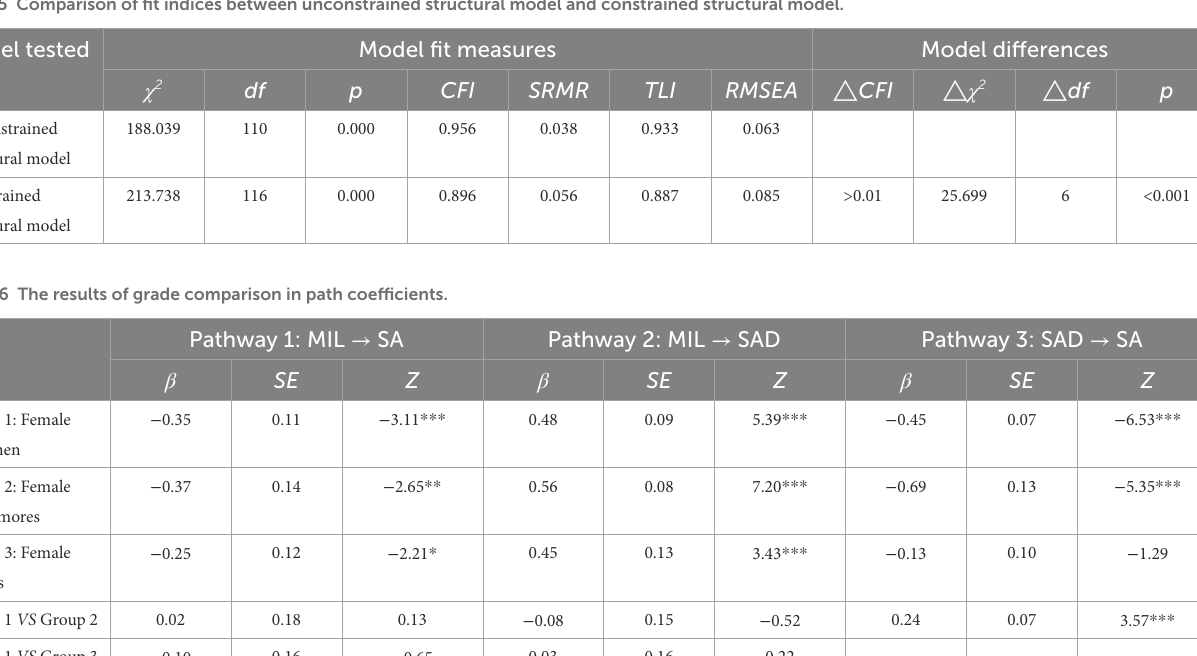
TABLE 5 Comparison of fit indices between unconstrained structural model and constrained structural model.